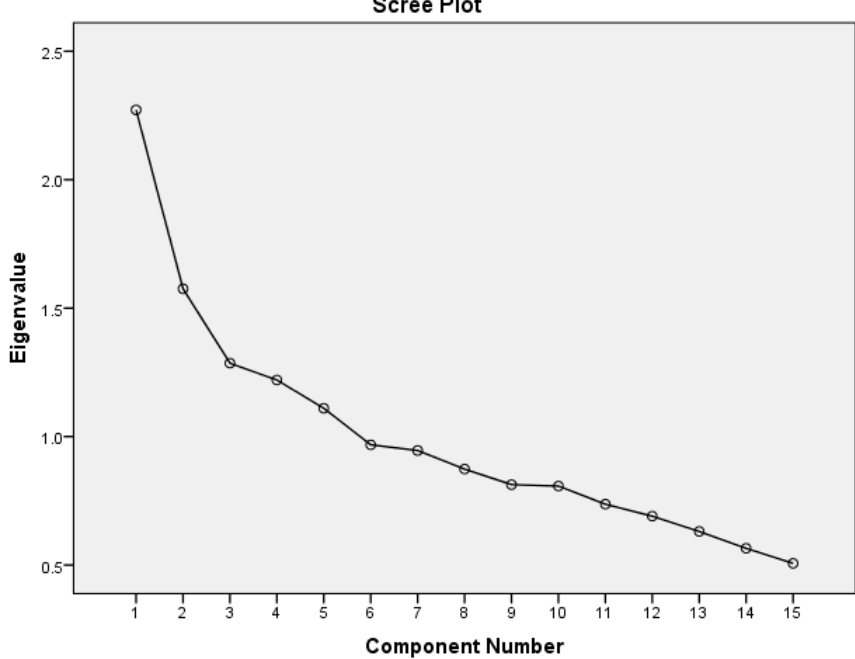
Figure 2. Scree plot of the PCFA using the 15 dietary and lifestyle characteristics of women participating in the study ( n = 418). Table 2. Factor loading matrix of the three identified lifestyle patterns among a nationally representative sample of Qatari women a ( n = 418).